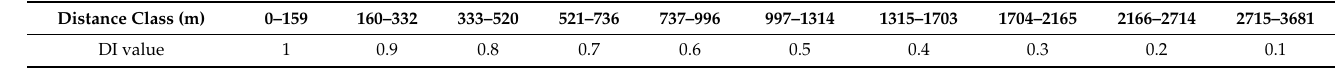
Table 3. Distance to river classes (m) and corresponding distance indicator (DI)